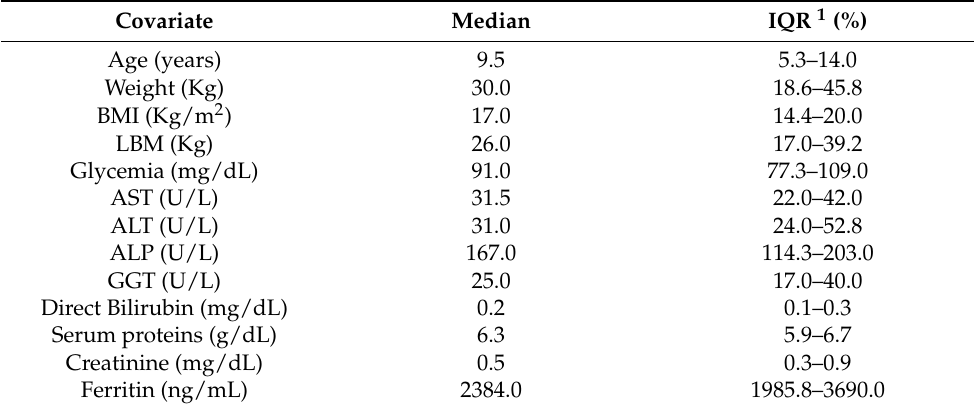
Table 1. Demographic characteristics of patients enrolled in the present study.